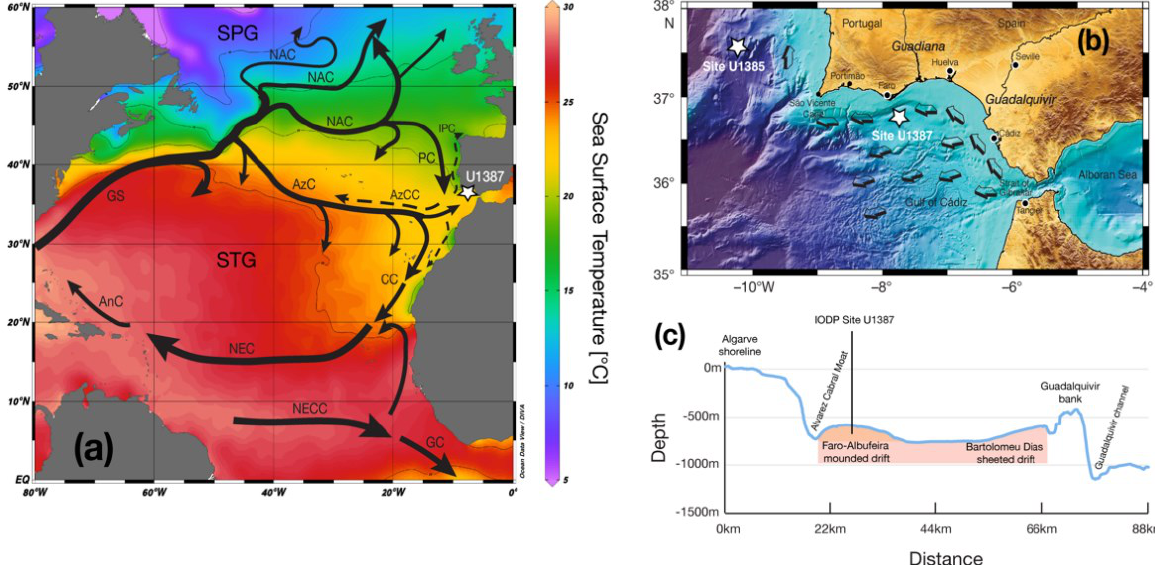
Figure 1. ( a ) Map of the North Atlantic Ocean showing the major surface water circulation currents with Gulf Stream recirculation and circulation pathways north of 40 ◦ N following [22]. Seasonal or dominantly subsurface currents are shown as dashed lines. The subarctic front separating the subtropical gyre (STG) from the subpolar gyre (SPG) is associated with the northern boundary of the central (“50 ◦ N”) branch of the North Atlantic Current (NAC). Other currents are abbreviated as follows (in alphabetical order): AnC-Antilles Current; AzC-Azores Current; AzCC-Azores Counter Current; CC-Canary Current; GC-Guinea Current; GS-Gulf Stream; IPC-Iberian Poleward Current; NEC-North Equatorial Current; NECC-North Equatorial Counter Current; and PC-Portugal Current. The background shows the summer (July–Sept.) sea surface temperature at 0.25-degree resolution based on the World Ocean Atlas 2018 [23] (map made with Ocean Data View [24]). ( b ) Close-up of the Gulf of Cadiz (bathymetry as background) with the locations of IODP Sites U1387 and U1385 and major pathways of the Mediterranean Outflow Water branches indicated by arrows. ( c ) Depth profile from the upper to the middle slope of the Algarve margin near the longitude of IODP